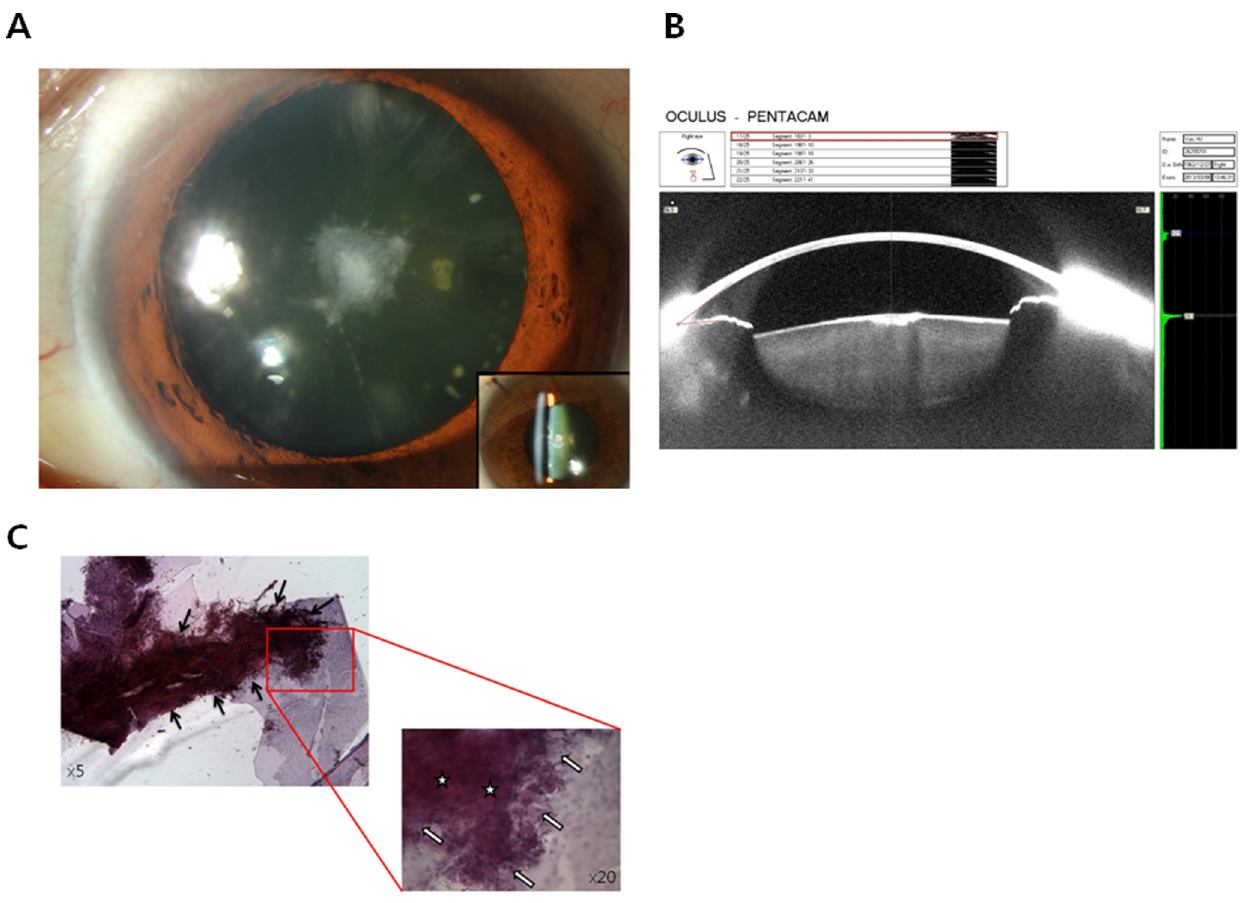
Figure 1. Fifty-year-old man showed findings of anterior polar cataract. (A) Slit-lamp examination demonstrates the form of white-grey opacity appearing under the central part of the anterior lens capsule. (B) Sheimpflug-measured lens density showing focal anterior polar opacity. (C) Light microscopy of the anterior capsule following cataract surgery of anterior polar cataract. Multilamellar arrangement and isolated aggregations of collagenous materials are present (arrows). High-power image shows proliferative changes of the lens epithelial cells (open arrows) and increased collagenous aggregations (stars).